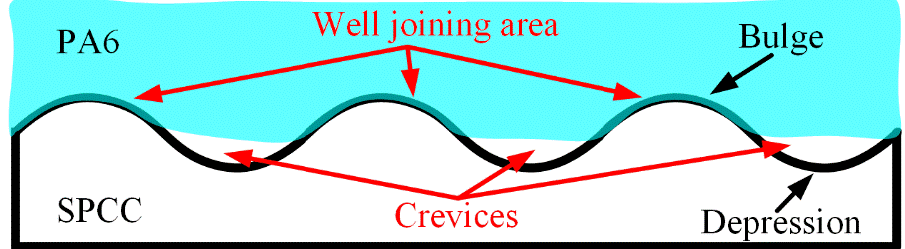
Figure 13. Schematic diagram of the joining result by the sole role of UPW energy.